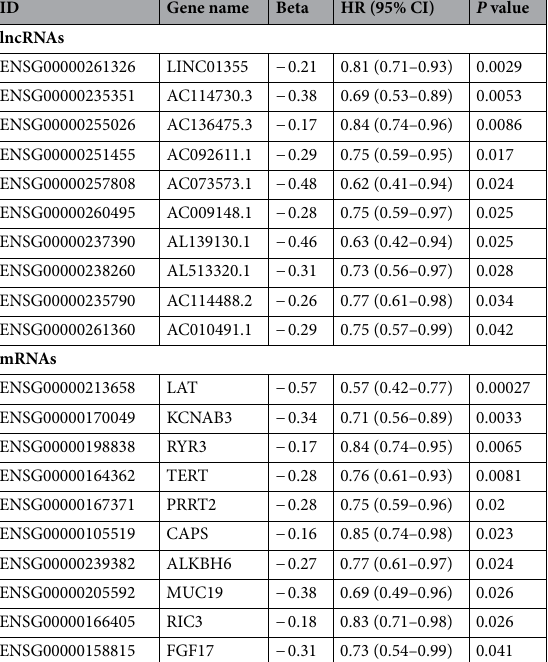
Table 2. Univariate Cox proportional hazards regression analysis for DElncRNAs and DEmRNAs in ceRNA